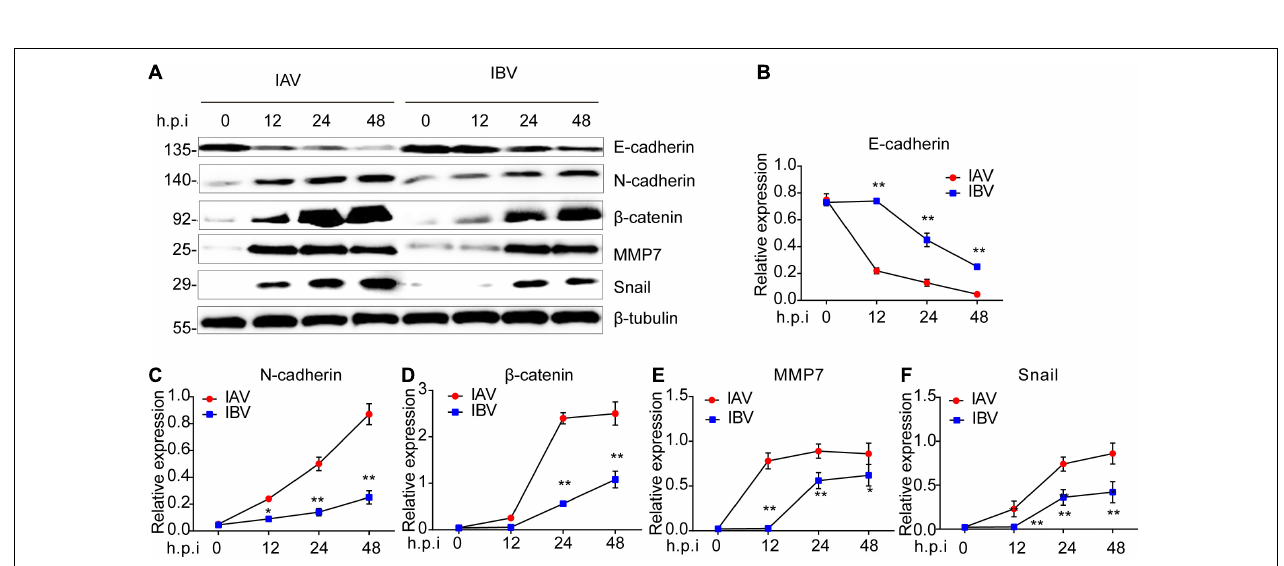
FIGURE 4 | Influenza A and B viruses trigger the protein expression levels of EMT-related genes in A549 cells. (A) Immunoblot analysis of EMT-relevant proteins in A549 infected with IAV (WSN) and IBV (Yamagata) (MOI = 0.005) for the indicated time-points. The relative expression of E-cadherin (B) , N-cadherin (C) , β -catenin (D) , MMP7 (E) , and Snail (F) in (A) . Data are representative of three independent experiments. Data are presented as the mean ± SD for panels (B–E) . * p < 0.05 and ** p < 0.01 (unpaired, two-tailed Student’s t